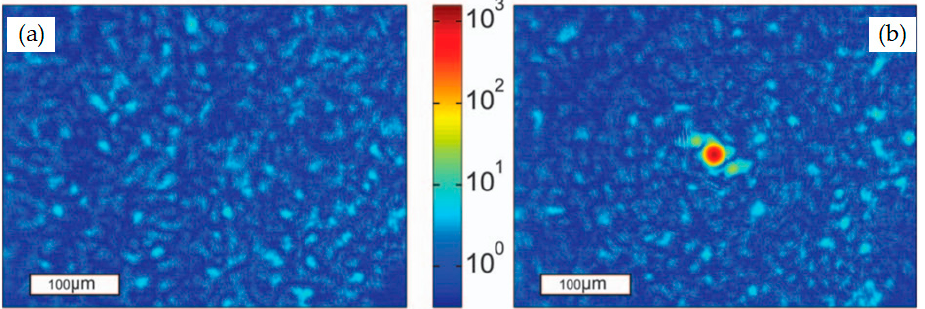
Figure 1. ( a ) A typical optical speckle pattern behind a ground glass diffuser without a shaped incident wavefront; ( b ) Optical pattern of the region with an optimized incident wavefront compensation by using wavefront shaping. A lot of energy of the multiply-scattered light is focused to a spot that is 1000 times brighter than other speckle grains. The size of the optical focus is determined by the sensitivity area of the feedback signal (Figure reproduced from [42]).